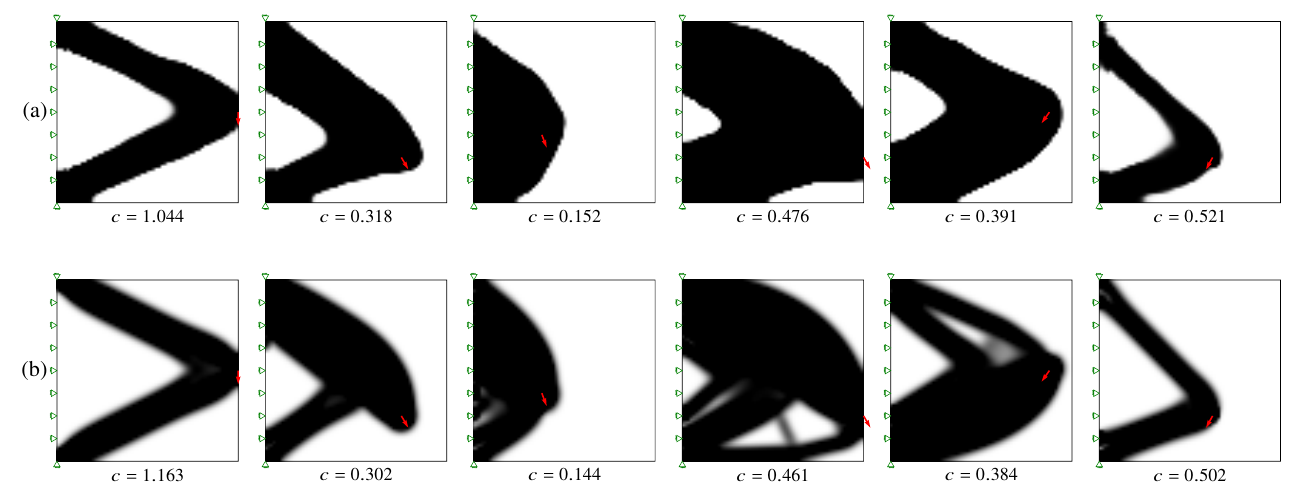
Figure 15. Additional sample geometries: ( a ) generated with predictor–evaluator network (PEN); ( b ) conventionally generated validation data.